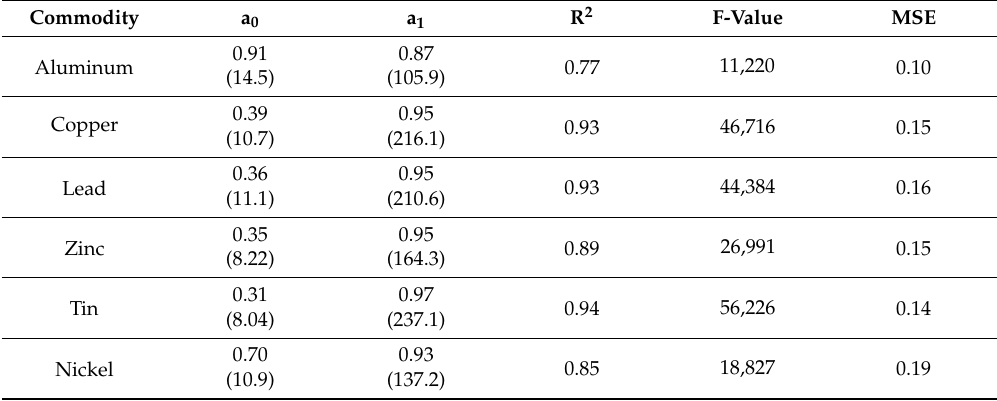
Table 1. Ordinary least squares (OLS) parameter estimates of Equation (1): daily data